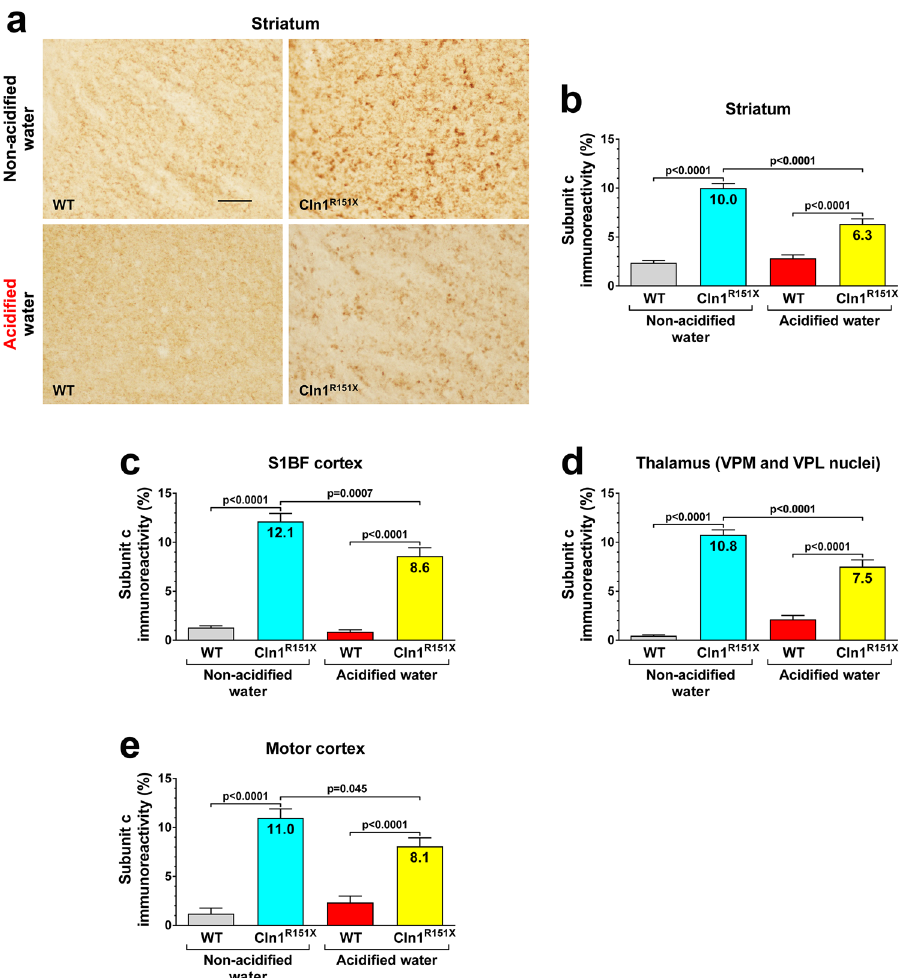
Figure 2. Acidified drinking water decreases the amount of lysosomal storage material in the brain of Cln1 R151X mice. A group of Cln1 R151X and wild-type (WT) male mice received acidified drinking water from weaning (21 days of age) and were compared to male mice that always had non-acidified drinking water. At 6 months of age, lysosomal storage material was measured in the brain using immunohistochemical staining for subunit c of the mitochondrial ATP synthase, a common constituent of the storage material in different forms of Batten disease. Quantitative image analysis was performed in two sensory area, the somatosensory barrel field (S1BF) cortex and the ventral posteromedial (VPM)/ventral posterolateral (VPL) nuclei of the thalamus, and in two regions responsible for motor control, the motor cortex and striatum. ( a , b ) Striatum. ( c ) S1BF cortex. ( d ) Thalamus. ( e ) Motor cortex. The graphs show percent area of subunit c immunoreactivity. Columns and bars represent mean ± SEM (24–96 fields from 3–4 mice in each experimental group). Two-way ANOVA analysis showed a significant interaction between the two factors, genotype and type of drinking water, in all four brain regions (Striatum: p < 0.0001; S1BF cortex: p = 0.0201; Thalamus: p < 0.0001; Motor cortex: p = 0.0131). In two- way ANOVA, Tukey’s post-test was used to calculate statistical significance in multiple comparisons. The size of the scale bar in the image is 50